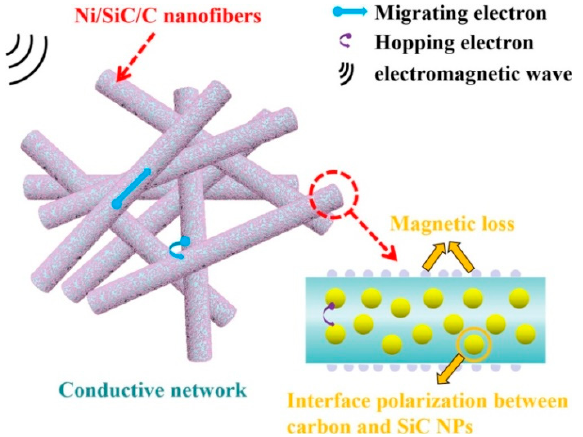
Figure 5. Schematic of the electromagnetic wave absorption in the Ni/SiC/C nanofibers. From [76], copyright (2021), with permission from Elsevier.